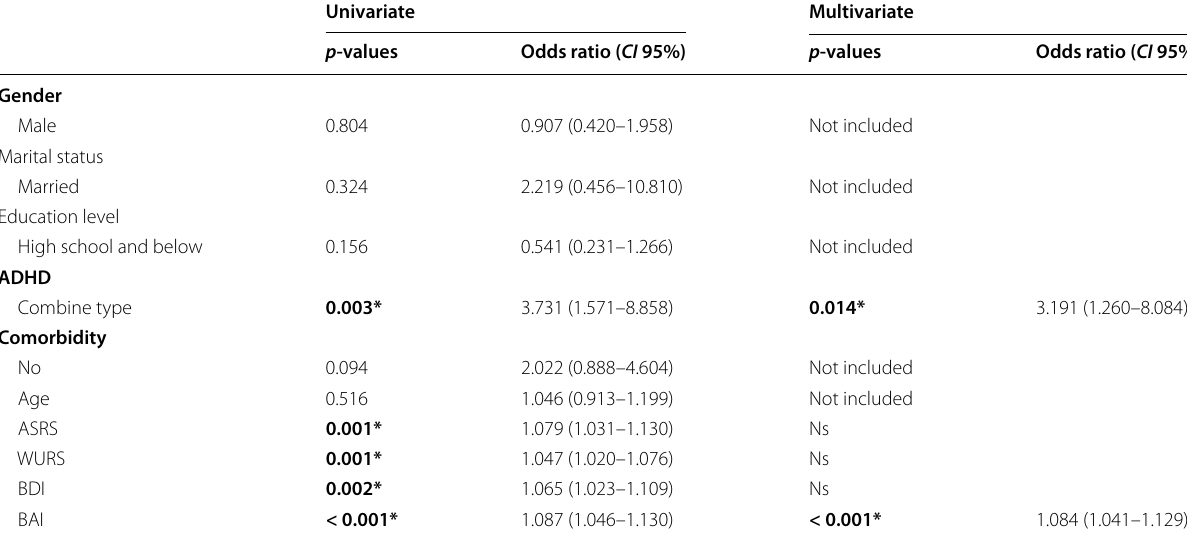
Table 4 RLS predictors by regression analysis in ADHD